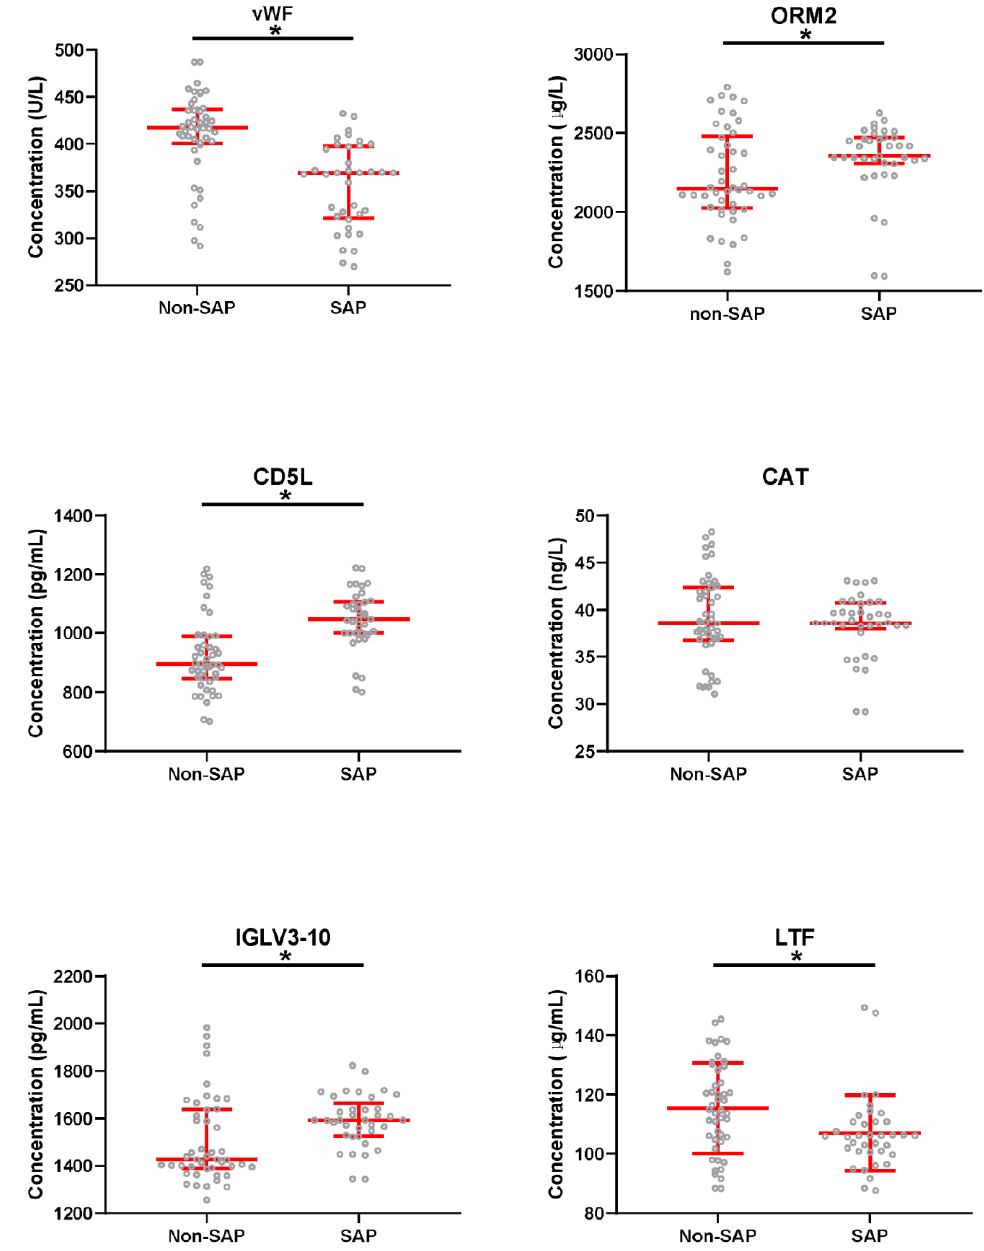
Figure 5. Comparison of marker levels in patients with severe acute pancreatitis or non-severe acute pancreatitis. VWF, von Willebrand factor; ORM2, alpha-1-acid glycoprotein 2; CD5L, CD5 antigen-like; CAT, catalase; IGLV3-10, immunoglobulin lambda variable 3–10; LTF, lactotransferrin; SAP, severe acute pancreatitis. * p < 0.05 (significant difference).